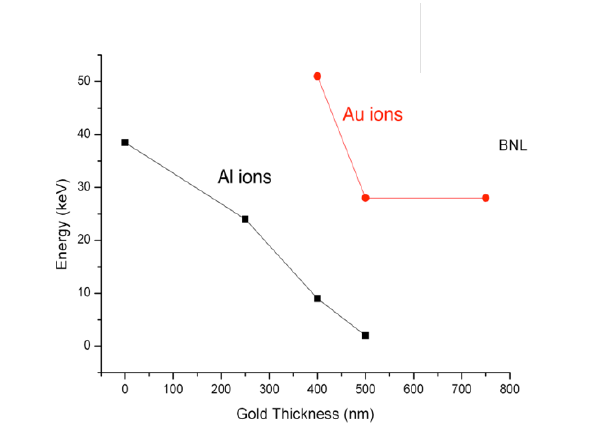
Fig. 5. Maximum energy value for Al and Au ions obtained from deconvolution of TOF